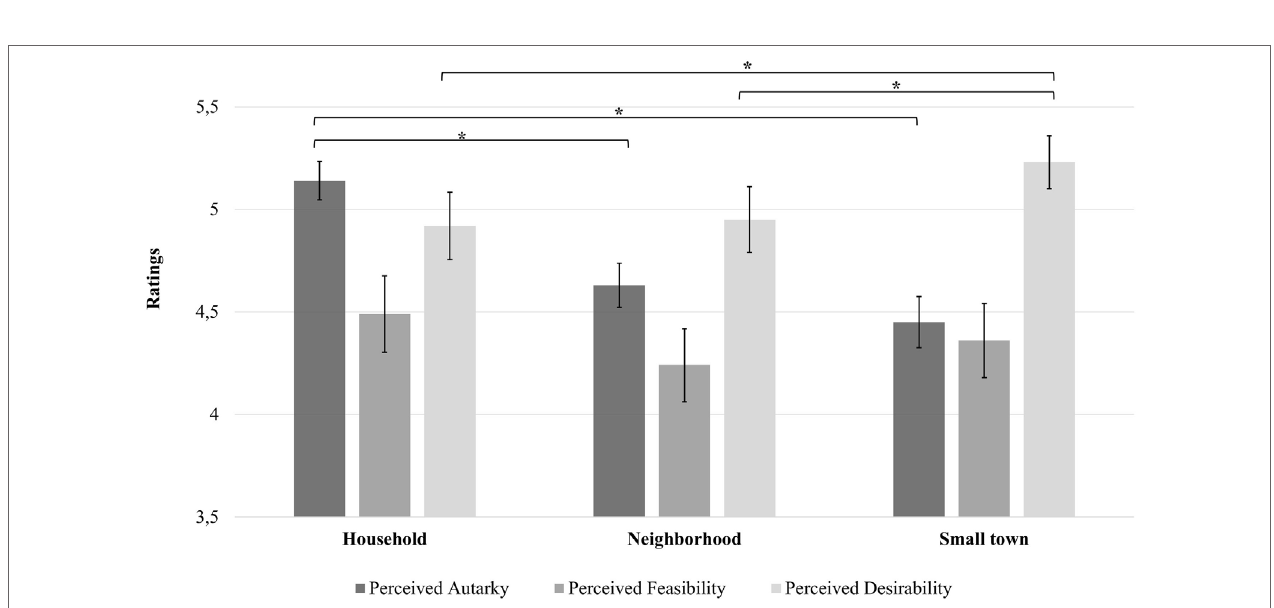
FigUre 6 | Mean values of perceived autarky, perceived feasibility, and perceived desirability for the three supply scenarios. Repeated measures ANOVAs revealed only a significant main effect for the perceived autarky, F (2, 334) = 58.16, p < 0.001, η p2 0 258. = , and a significant main effect for the perceived desirability, F (2, 334) = 7.14, p < 0.001, η p2 0 041. = . Pairwise comparison revealed that the perceived autarky was higher in the Household Scenario than in the Neighborhood Scenario ( p < 0.001) and than in the Small Town Scenario ( p < 0.001). Pairwise comparison revealed that the perceived desirability was higher in the Small Town Scenario than in the Household Scenario ( p = 0.003) and than in the Neighborhood Scenario ( p = 0.006). Error bars depict the 95% confidence intervals. N = 168 (100 females). * p ≤